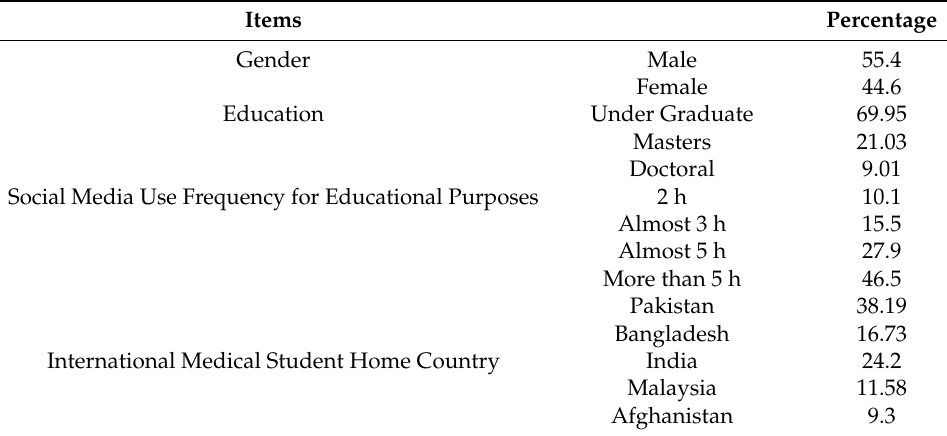
Table 1. Respondents’ demographic